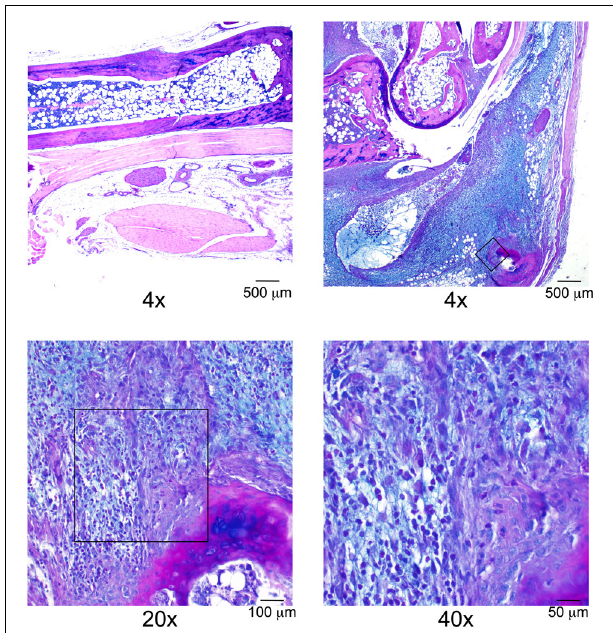
FIGURE 5 | Alcian blue staining reveals excess deposition of GAGs within severely arthritic ankle joints, modified from Bramwell et al. (2014). Top left panel: Ankle joint section from a day 7 K/BxN treated B6 mouse at × 4 magnification. Remaining panels: Ankle joint section from a day 7 K/BxN treated B6.C3H- Gusb h mouse. Original magnification × 4, × 20, and × 40. Scale bars: 500, 100, 50 μ m, respectively. Boxes on the top right and lower left images indicate the location of the field magnified in subsequent